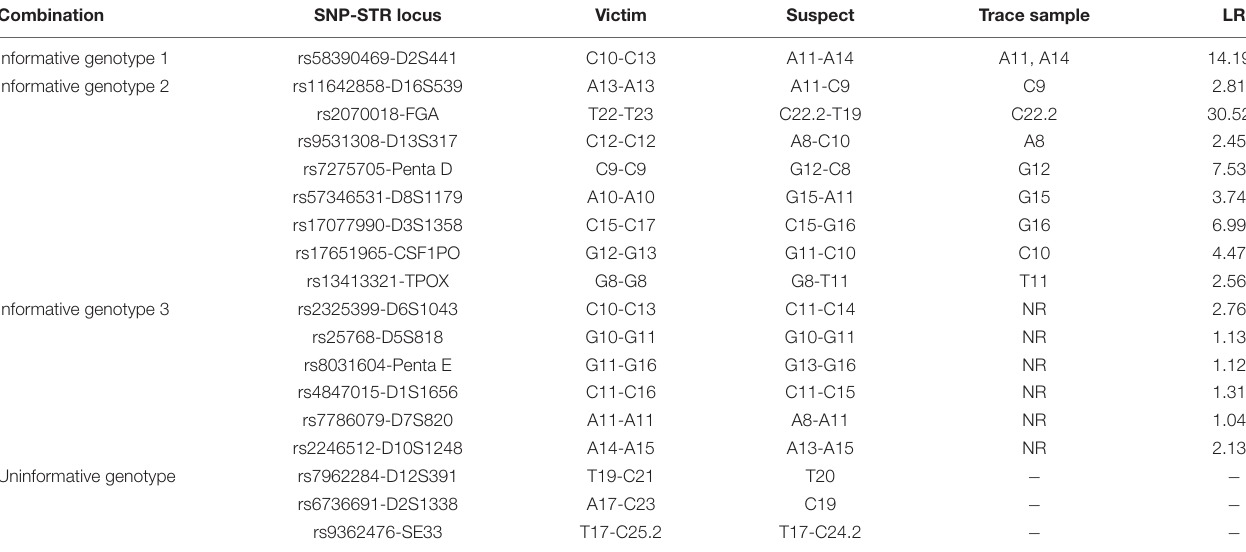
TABLE 7 | Informative genotype profiling results and LR values of the trace sample. Combination SNP-STR locus